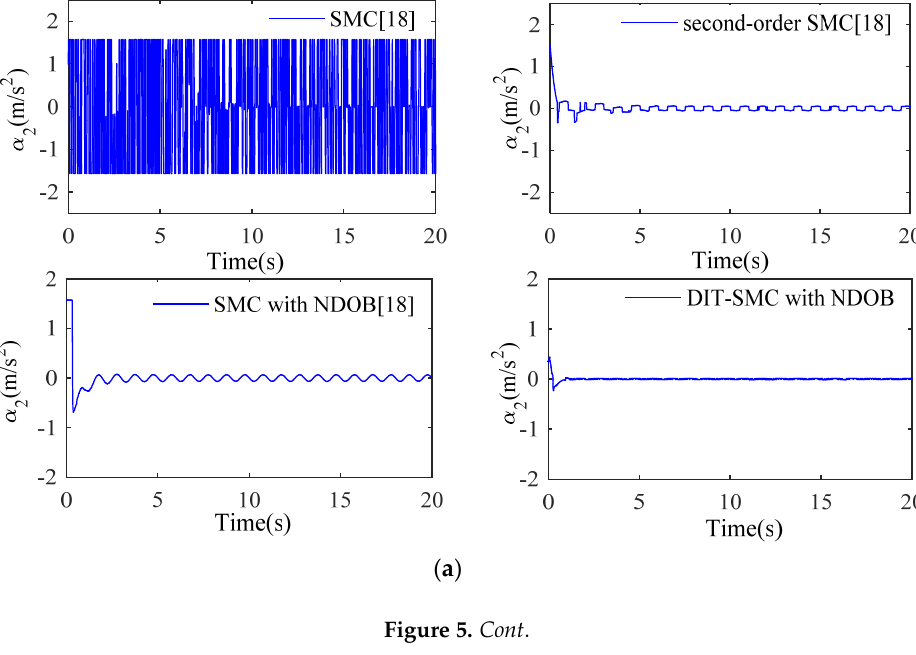
ψ ; ( c ) l ψ . 13; ( d ) 13 12